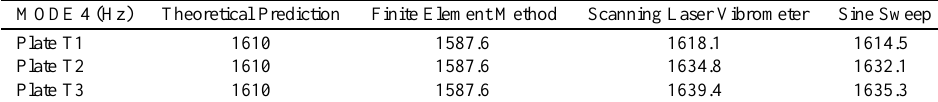
Table 2 Theoretical and Experimental Mode 4 Natural Frequencies (Hz) for the Uncoated Plates w/out Strain